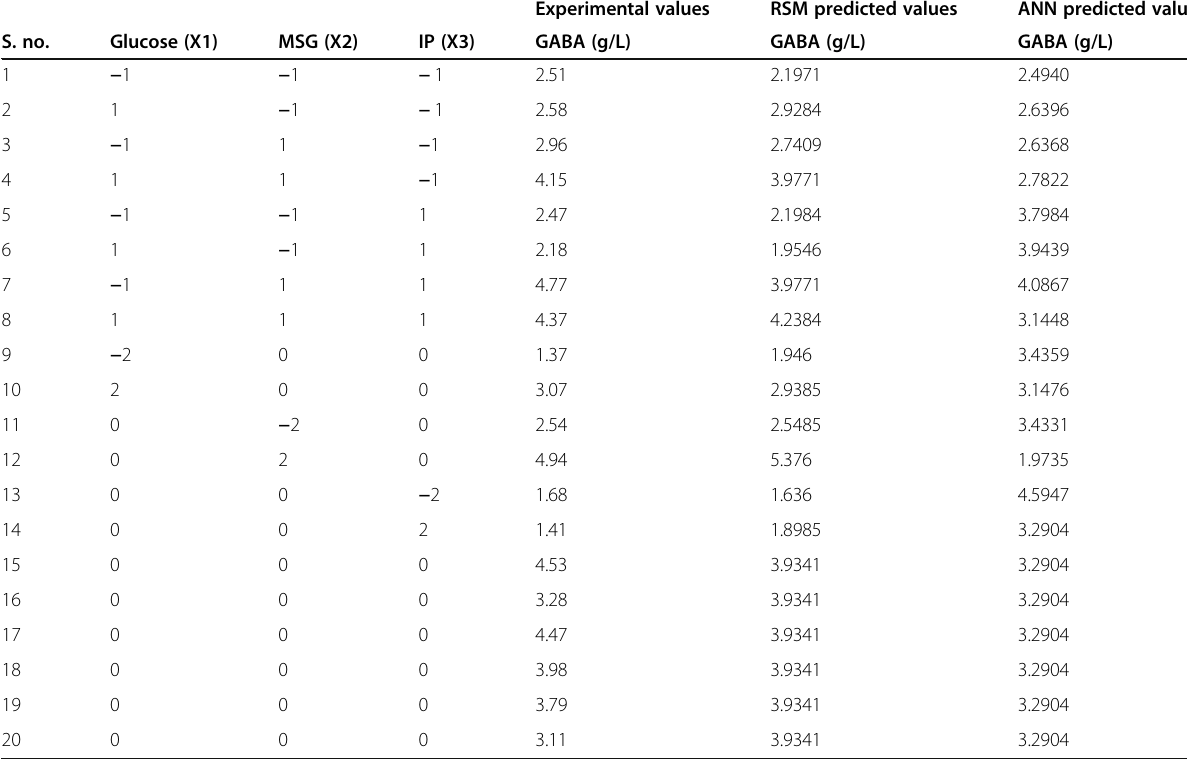
Table 2 Central composite design of factors in coded for GABA yield in fermented soya milk by Lb. fermentum Experimental